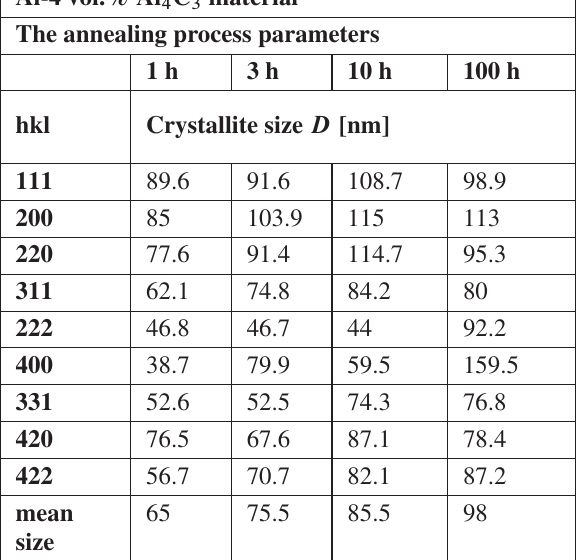
Table 2. The size of crystallites of Al-4 vol. % Al 4 C 3 com- posite annealed at 913 K for different